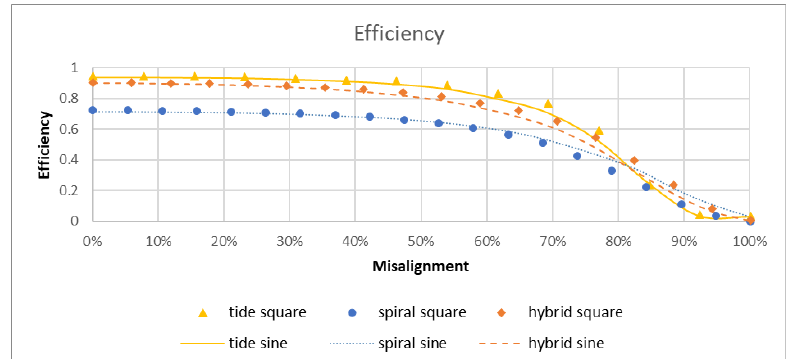
Figure 23. Measured efficiency for pure resistive load.